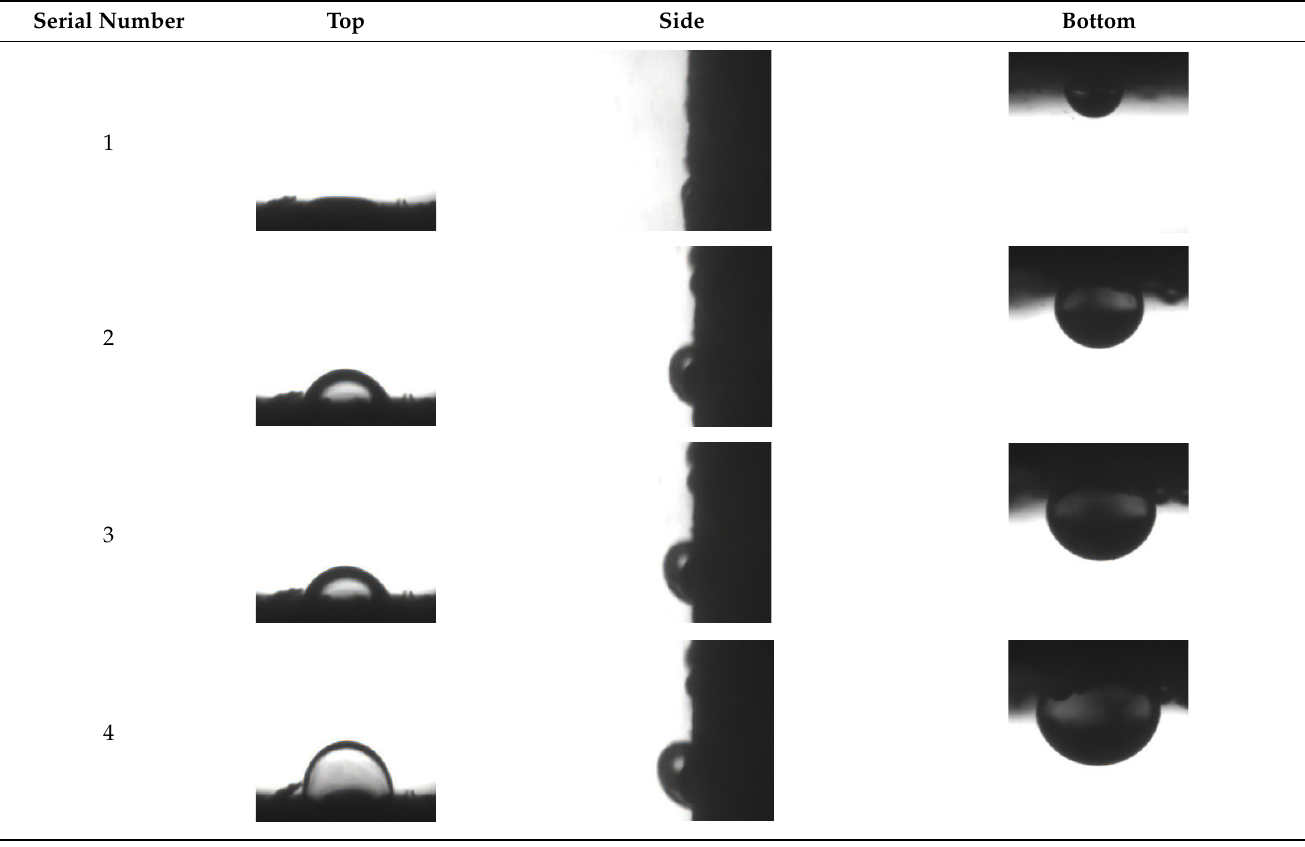
Table 3. Image of oil drop during surfactant dynamic imbibition in different positions of tight core.